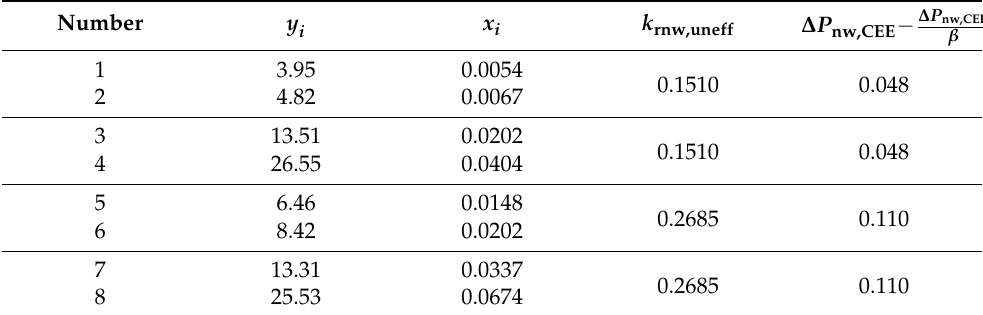
Figure 8. Application examples of stability factor: ( a ) Calculation of stability factor; ( b ) application of stability factor. Table 9. Calculation results of relative